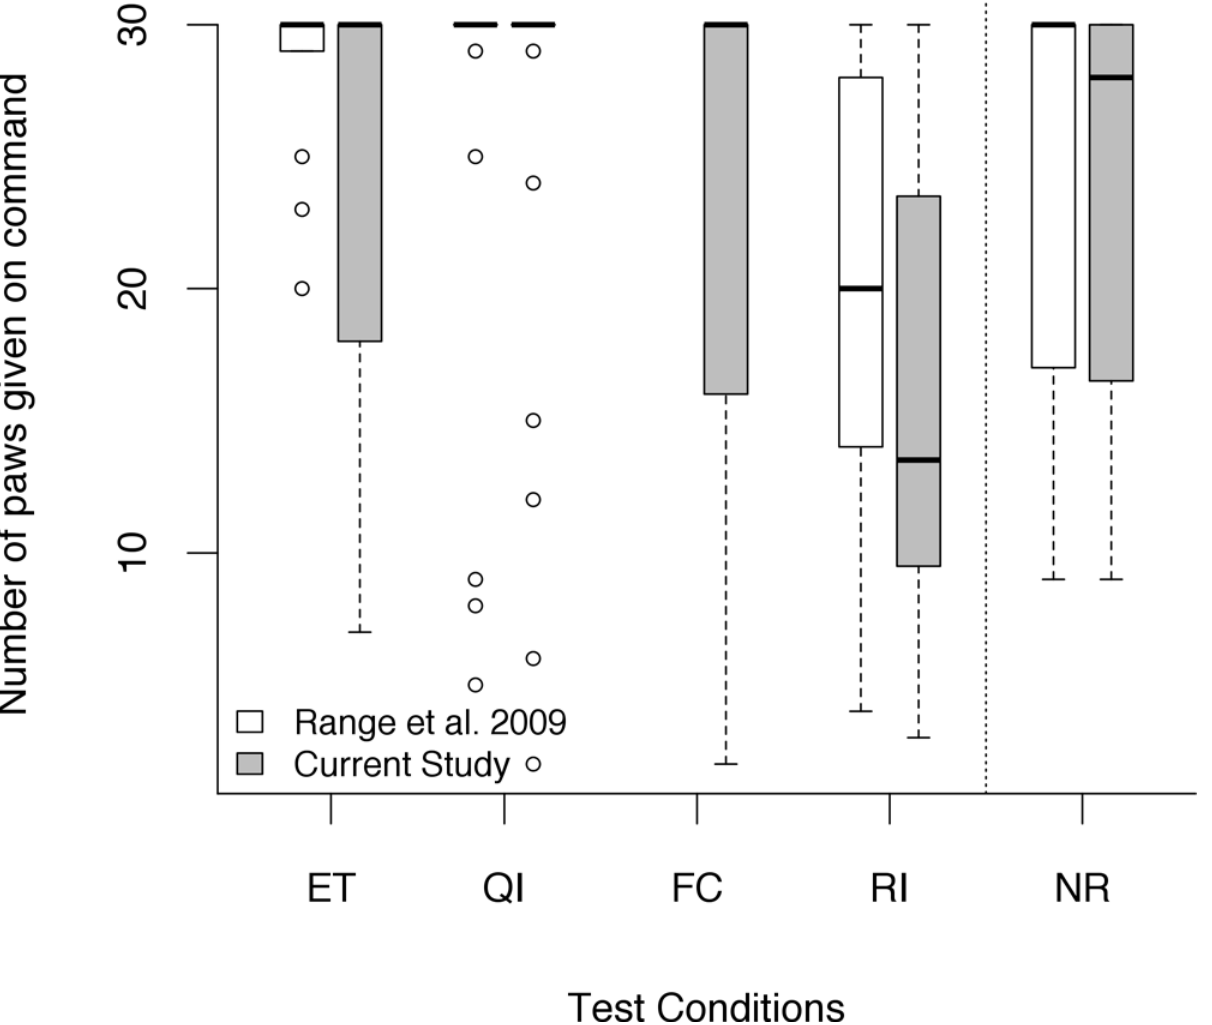
Fig 3. Number of times the paw was given on command per test condition in Range et al. [17] ( N = 29) and the current study ( N = 32). Circles show outliers, black bars indicate median values, whiskers display upper and lower hinge, and boxes show the interquartile